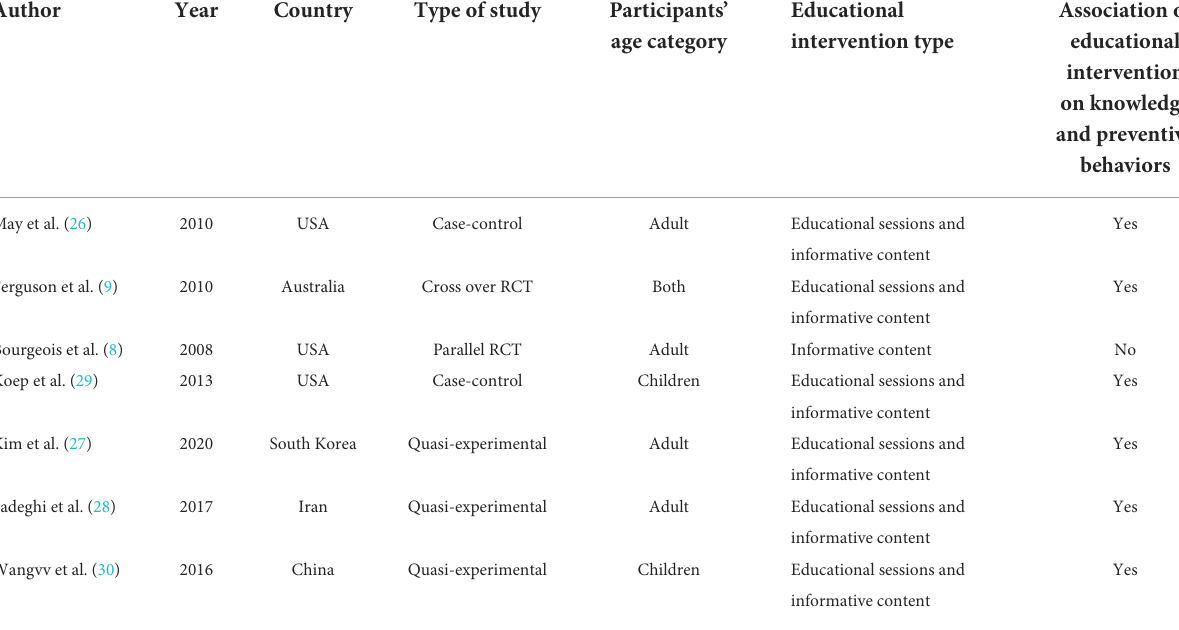
TABLE 3 The association of educational interventions on the improvement of knowledge or preventive behaviors.